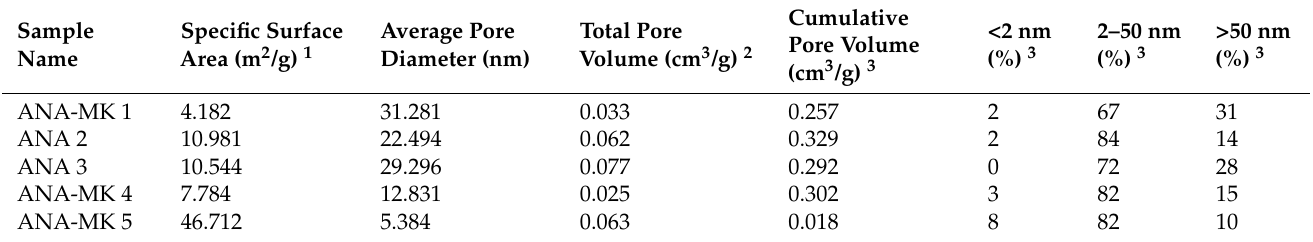
Table 4. SSAs, pore sizes, and volumes of the prepared sorbents.